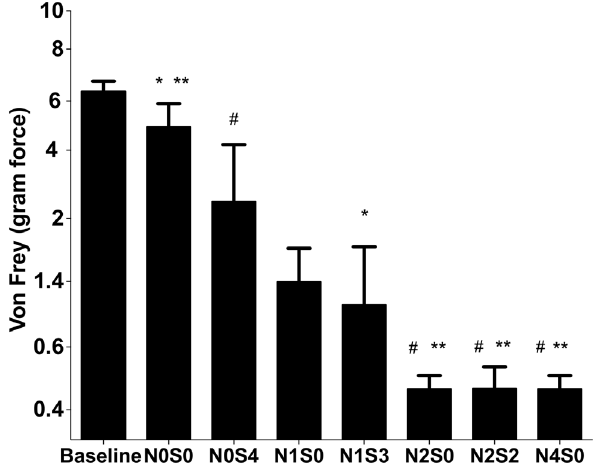
Figure 4. Allodynia quantification at day of cull (At least postoperative day 18). Graded neuropathy was induced by varying the number of chromic gut pieces ligating the nerve (N) and/or distributed in the subcutaneous (S) compartments. The